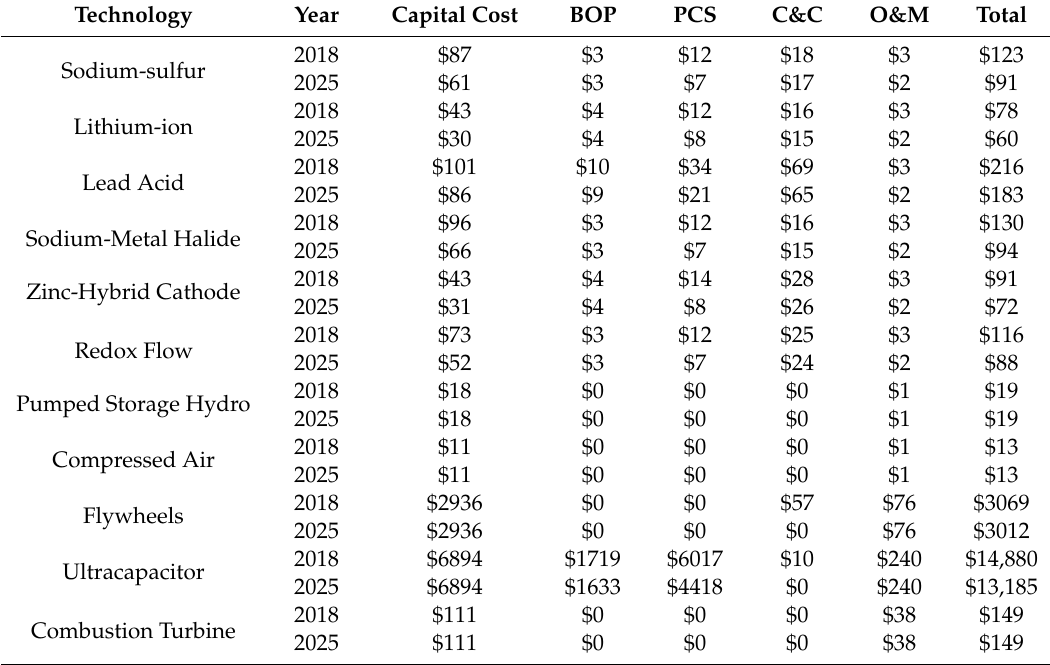
Table 38. Annualized costs for each technology, 2018 and 2025 ($ / kWh).